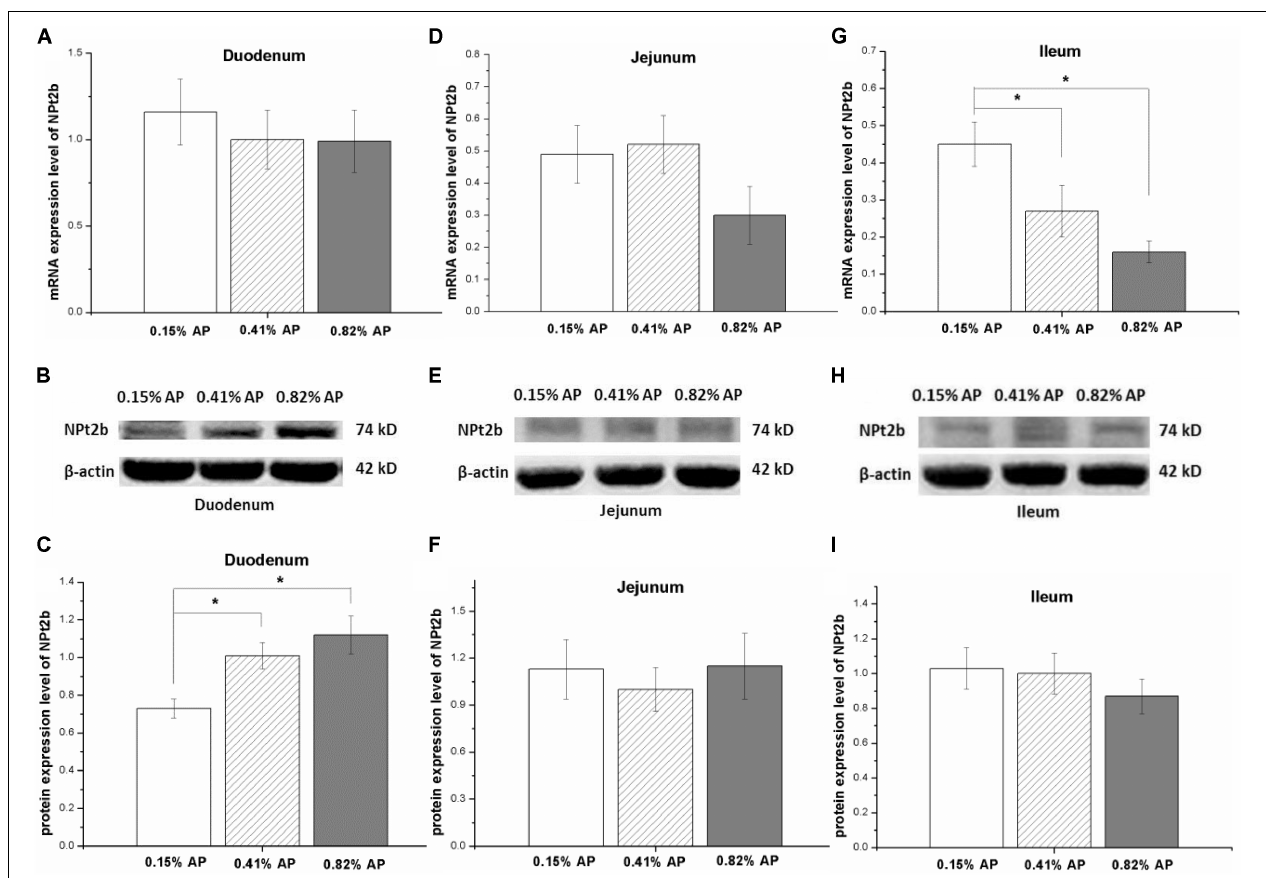
FIGURE 2 | Effect of dietary available phosphorus levels (AP, 0.15, 0.41, and 0.82%) on the mRNA and protein expression level of type II-B Na/Pi co-transporter (NPt2b) in small intestine of laying hens. Duodenum (A–C) ; jejunum (D–F) ; ileum (G–I) . Data were presented as means ± SEM (n = 8); ∗ P <